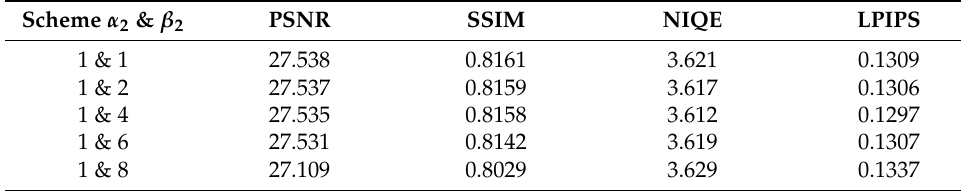
Table 2. A study of the loss weights in the Set14